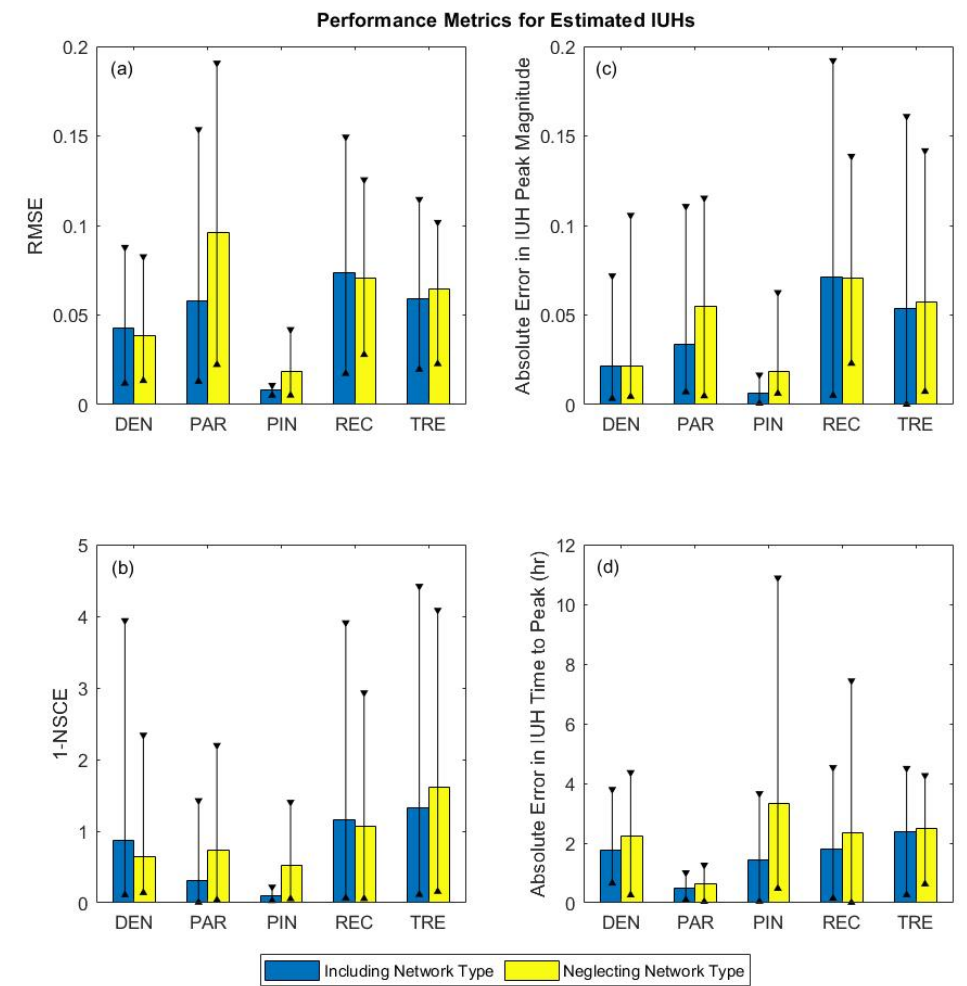
Figure 8. Performance metrics when the instantaneous unit hydrographs are estimated by either including or neglecting the network type as indicated in the legend. Column heights indicate the average performance and black bars indicate the range of performance for each case.